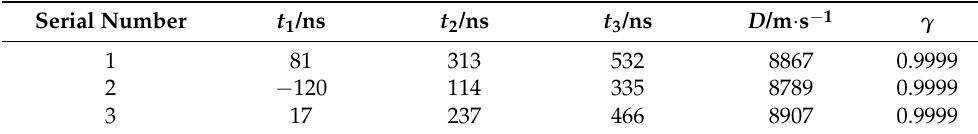
Table 6. Experimental data with L = 2 mm, a = 0.5 mm.